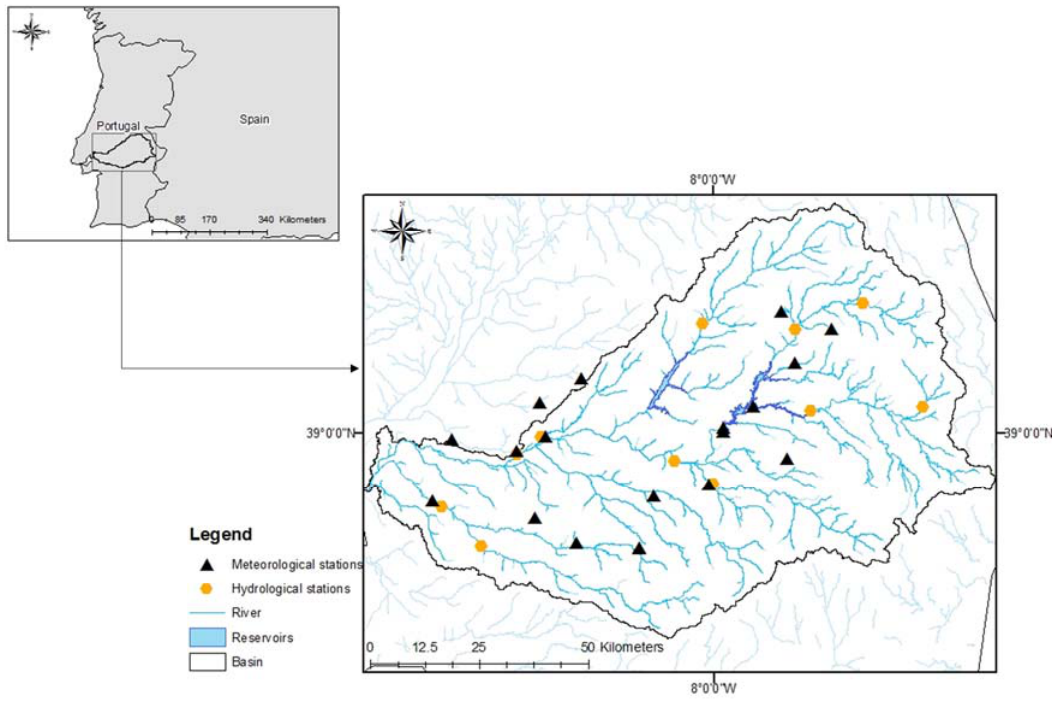
Figure 1. The Sorraia River Basin.